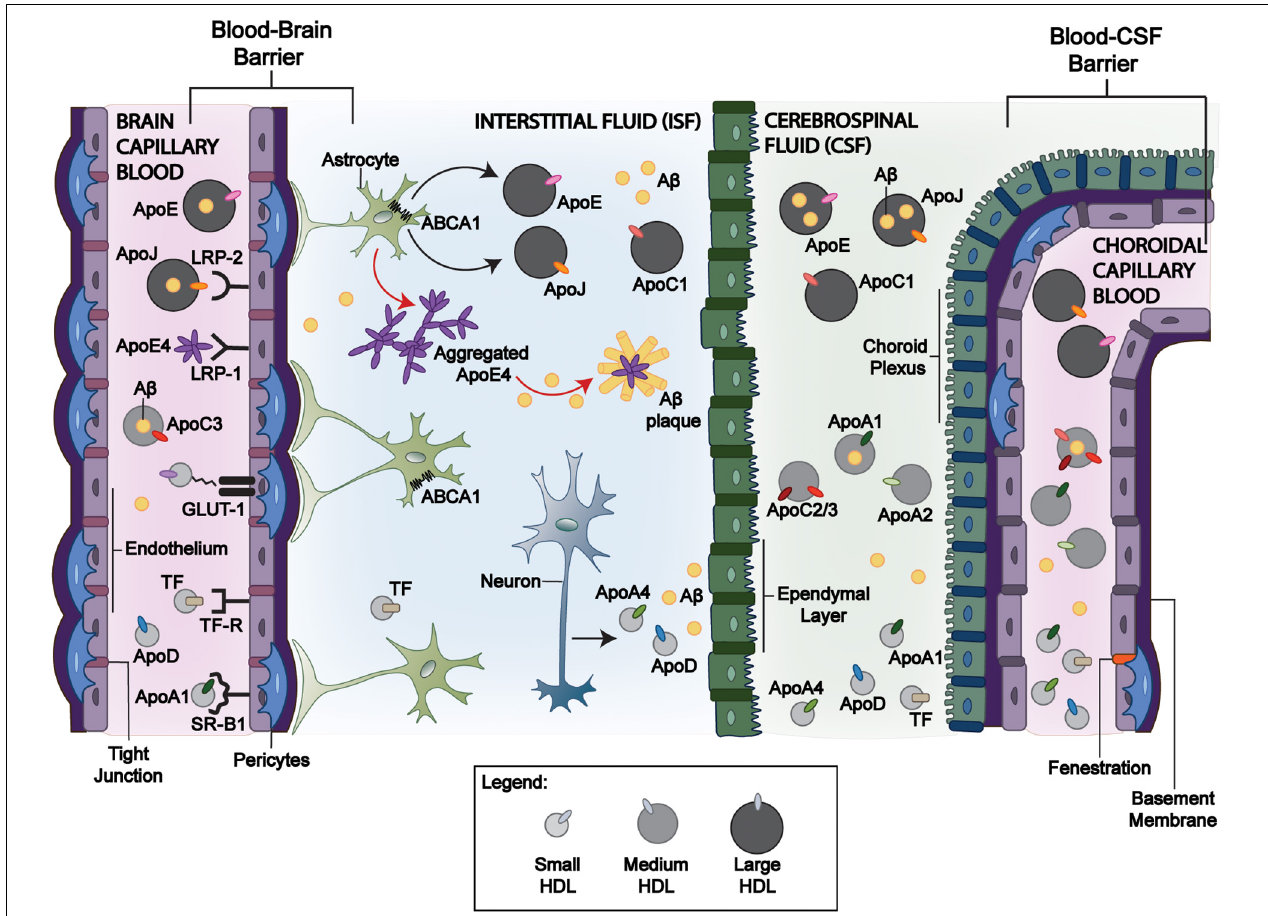
FIGURE 1 | Mechanisms of HDL-P transport across blood-brain interfaces and its relevance to A β clearance. Circulating large apoE, apoJ, and apoC-III containing HDL-P facilitate A β efflux across the BBB and BCSFB through various receptor-mediated interactions and can promote A β efflux from the brain despite a limited BBB exchange. Of the apoE isoforms, apoE4 has the greatest affinity to LRP-1 that may allow greater BBB transport. While larger HDL-P have limited brain delivery, smaller HDL-P may exchange among the blood, CSF, and interstitial fluid compartments. ApoJ has been demonstrated to interact with LRP-2 at the BBB and BCSFB for A β clearance, but lipidated apoJ and apoE3 have limited brain delivery from the periphery. While peripheral apoA-I and apoA-II cross the BCSFB and are present in CSF, the size/shape that promote this exchange remains unclear. Astrocyte-derived apoJ and apoE undergo lipidation by ABCA1. In comparison to apoE2 and apoE3, apoE4 has inefficient interactions with ABCA1 (red arrow). It remains lipid-poor and is more prone to aggregation, promoting A β plaque formation. In contrast, the greater lipidation of apoE2 and apoE3 compared to apoE4 by ABCA1 limits the formation of A β plaques. LRP-1: Low-density